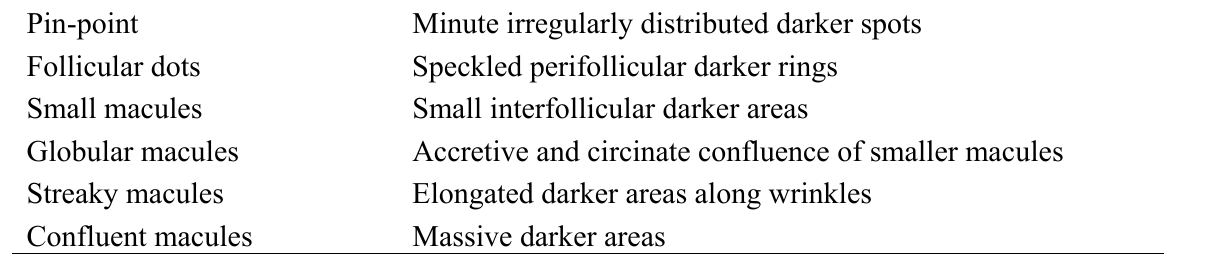
Table 1. Patterns of mottled subclinical melanoderma according to